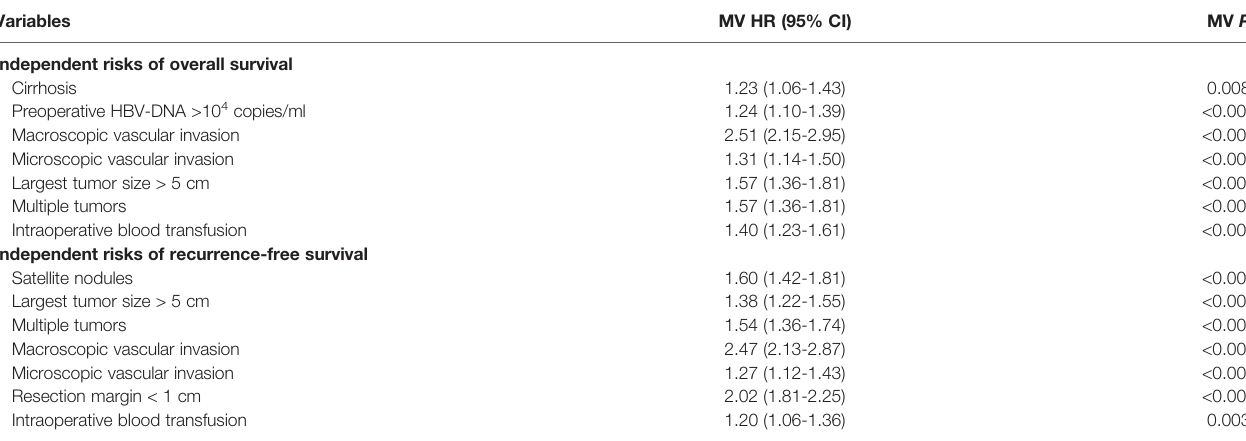
TABLE 4 | Independent prognostic factors associated with overall survival and recurrence-free survival after liver resection for hepatocellular carcinoma among patients with only HBV infection by multivariable Cox-regression analysis. Variables Independent risks of overall survival